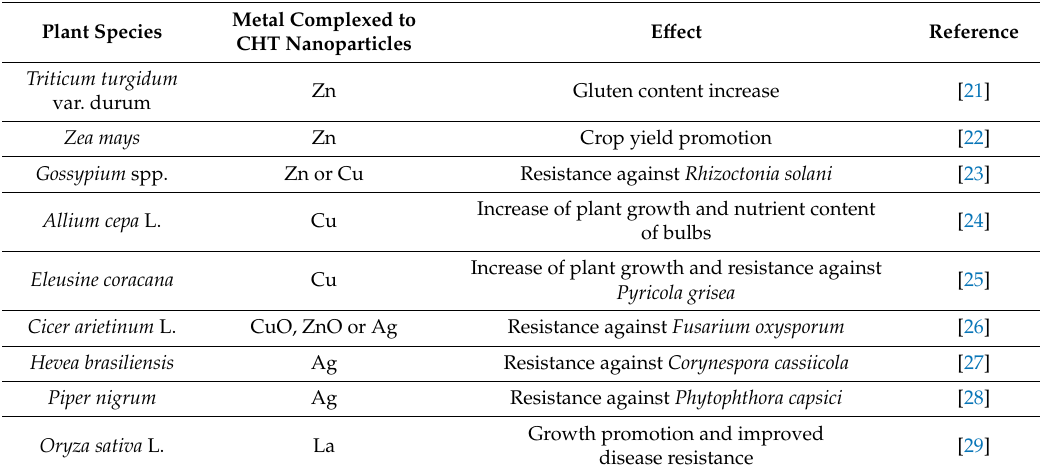
Table 2. Recent application of chitosan-based nanoparticles complexed with metals. Plant